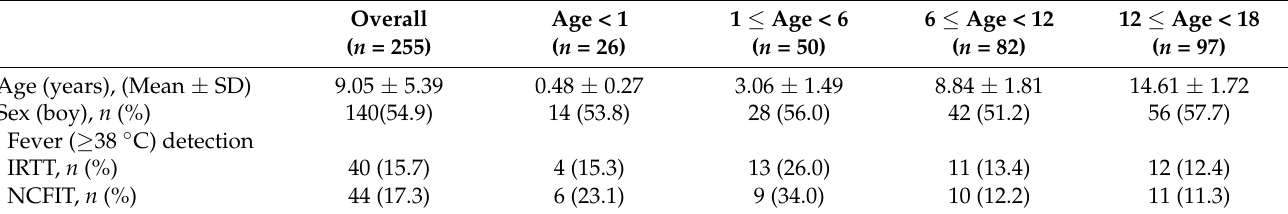
Table 1. Participants characteristics ( n =